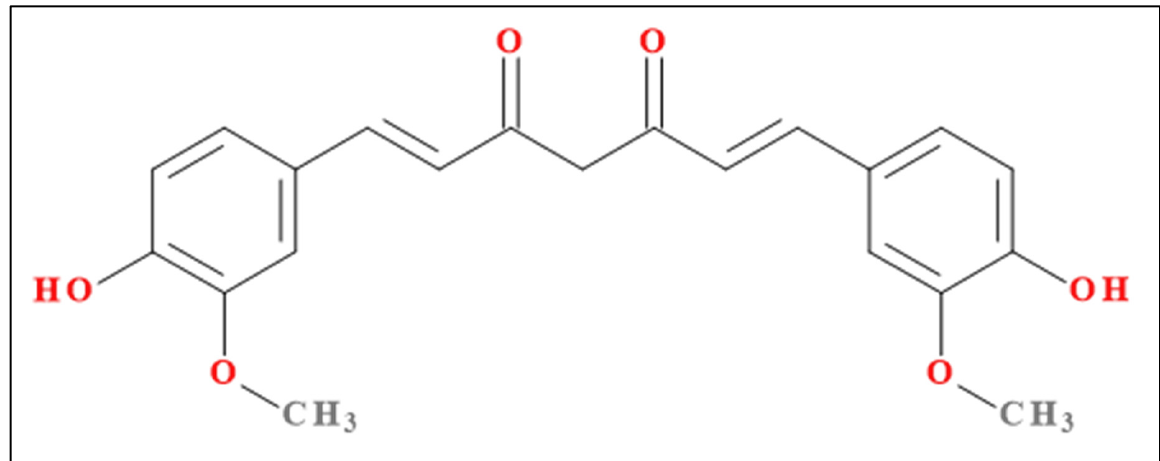
Figure 1. Chemical structure of curcumin (original